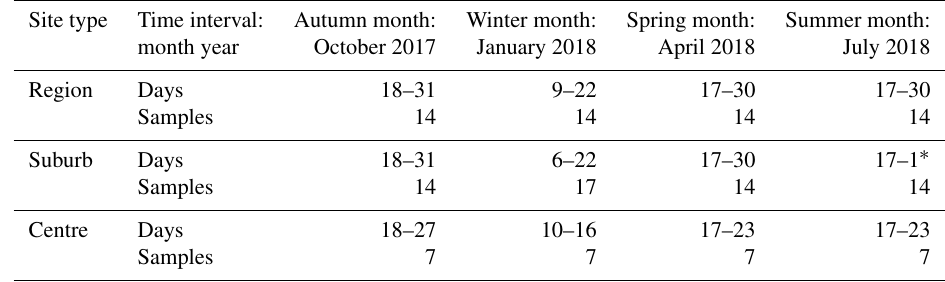
Table 1. Start and end dates of the sampling periods and number of aerosol samples collected in regional background of the Carpathian Basin, suburban area and city centre of